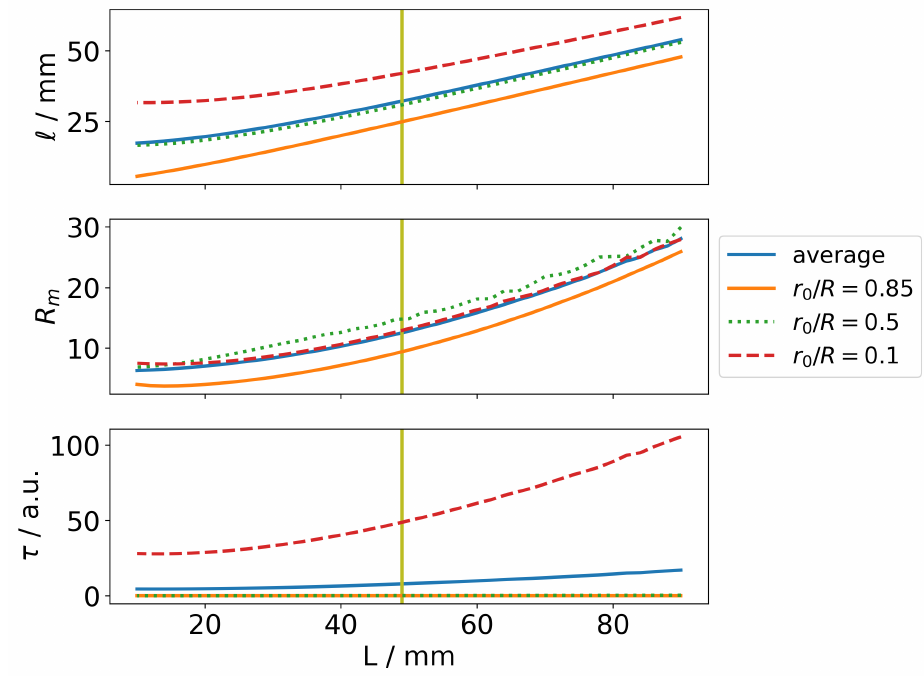
Figure 7. Field line properties are scanned over a range of magnet lengths L and for a fixed radius R = 20mm. From top to bottom, the field line length (cid:96) , the magnetic mirror R m , and a confinement time τ from Equation (3) are plotted. Shown are the average lengths over 20 field lines (in blue) and three selected field lines for comparison. The time τ is in arbitrary units